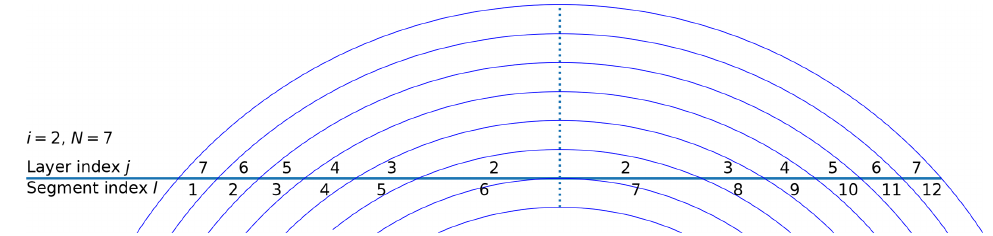
Figure 1. Illustration of the airglow limb-viewing line of sight. The observer is located at the left end of the horizontal line. The layer thicknesses are greatly exaggerated relative to the Earth’s radius for visualization. The dashed vertical line indicates the tangent point and the thickness of each